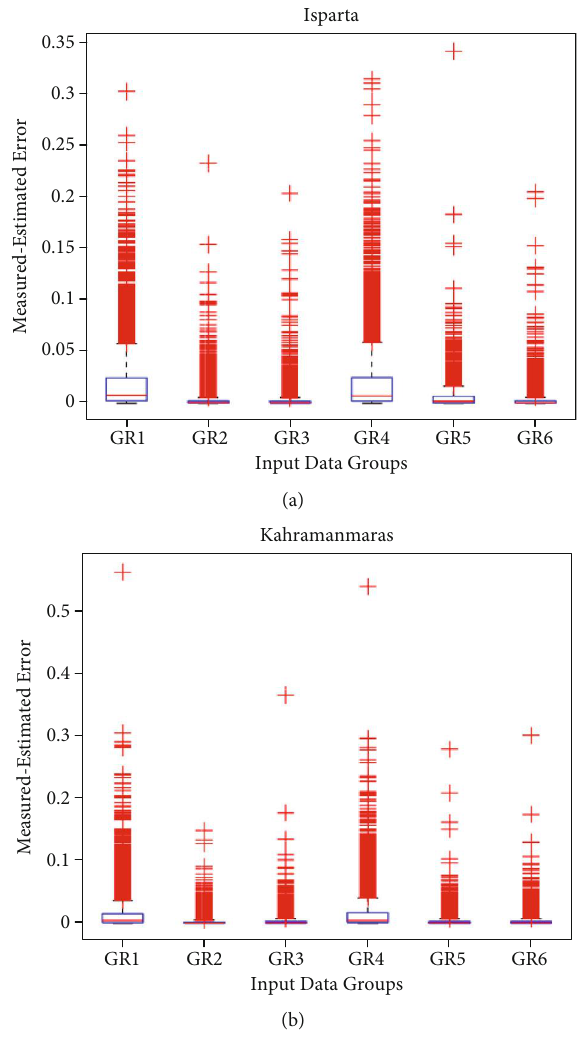
Figure 9: Statistical error box plotsbetween the measured and estimated values of (a) Ispartaand (b) Kahramanmaras accordingtothe input